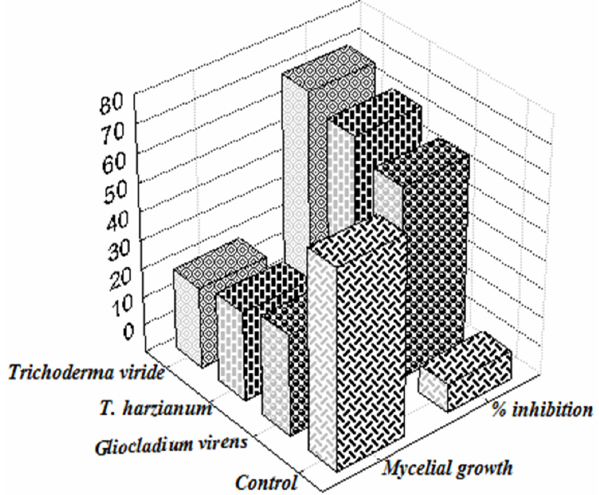
Fig. 1. Effect of bioagents on mycelial growth of C. lindemuthi-